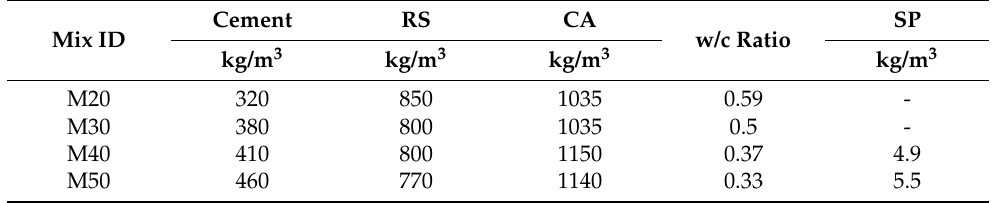
Table 2. Mix design of concrete.